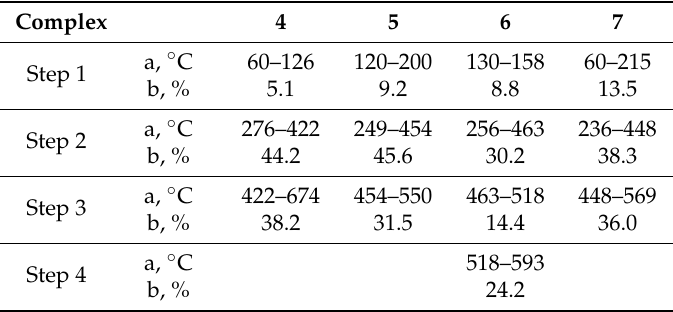
Table 2. Decomposition processes in TG-DTA of the benzoate complexes 4 – 7